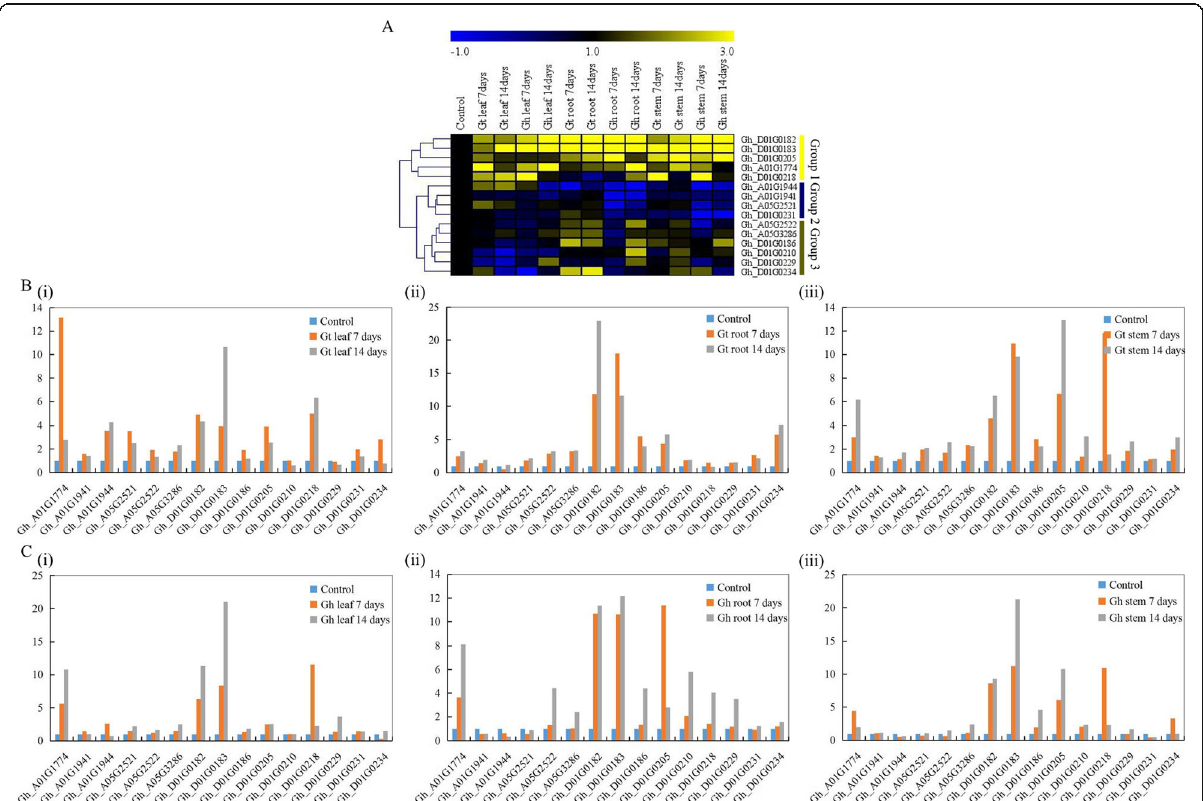
Fig. 7 Differential expression of the 15 key genes under drought stress. (I): The heat map was visualized by using R heap map function (showed by log 10 values) in 0, 7th and 14th day of drought treatment. Gt – Gossypium tomentosum and Gh – Gossypium hirsutum . Yellow – up-regulated, Blue – down-regulated and Black – no expression. (II): Statistical analysis of the RT-qPCR results. Y-axis: relative expression (2 − ΔΔ CT ). a Expression profile of the various genes in leaf of G. tomentosum , b Expression profile of the various genes in leaf of G. hirsutum , c Expression profile of the various genes in root of G. tomentosum , d Expression profile of the various genes in root of G. hirsutum , e expression profile of the various genes in stem of G. tomentosum and f Expression profile of the various genes in stem of G.